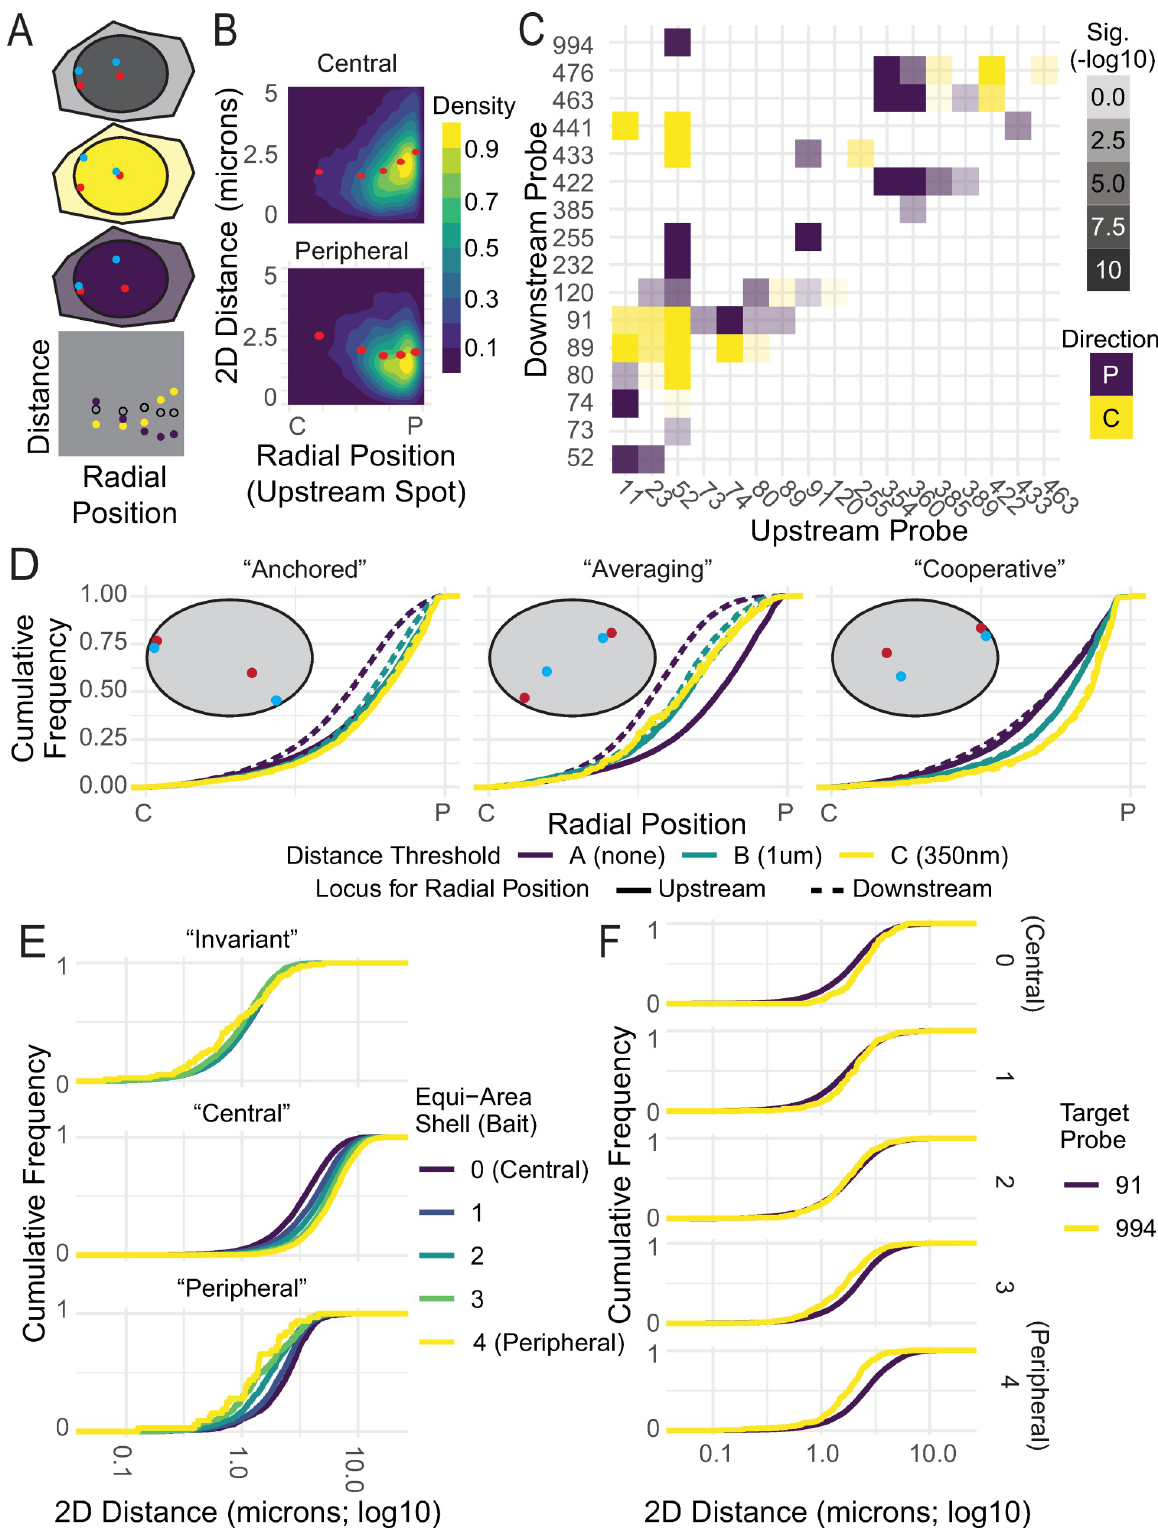
Fig 2. Pairwise proximity shows preferred radial positions. A: Schematic showing a pair without preference (transparent), more likely to interact at the center (future shown in yellow), edge (future shown in purple). In scatter plots they result in shifts in medians by bin as shown